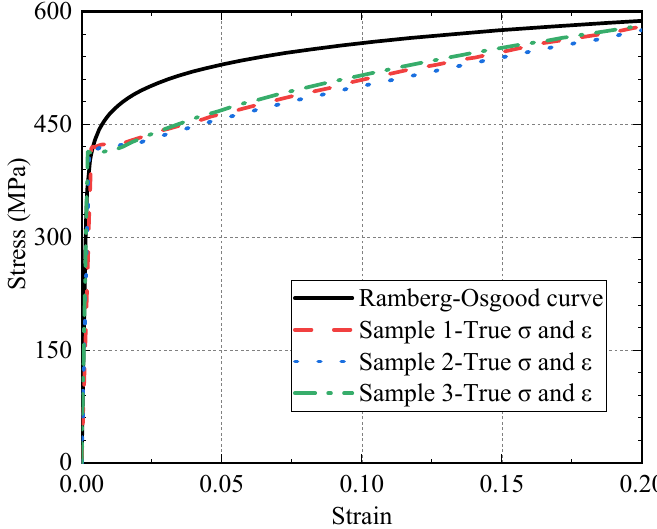
Figure 6. Comparison of applied constitutive model and sample tests.